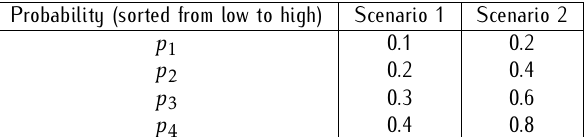
Table 3. Transmission Opportunities values Probability (sorted from low to high) Scenario 1 Scenario 2